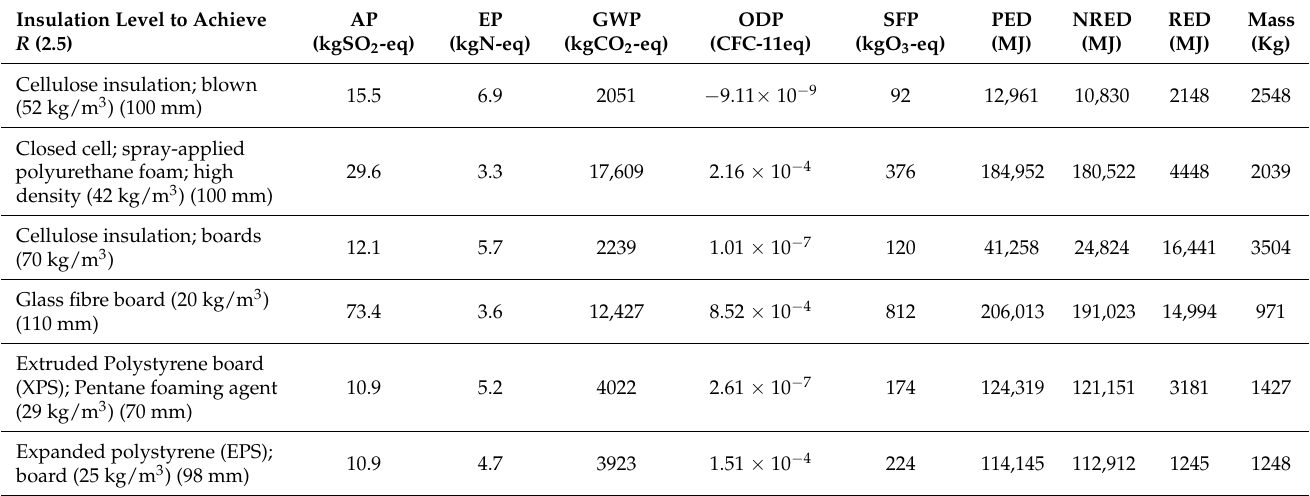
Table 8. Embodied energy of insulation